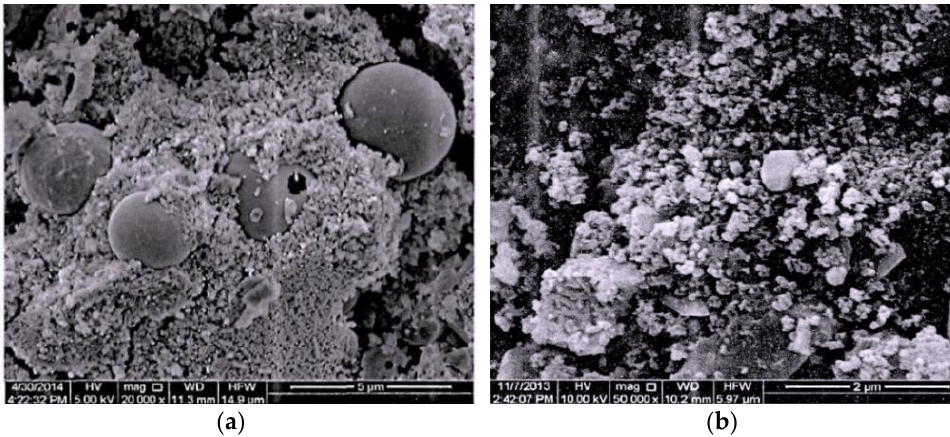
Figure 6. The microstructure of the geopolymer. ( a ) Group C; ( b ) Group N ‐ 1.5.